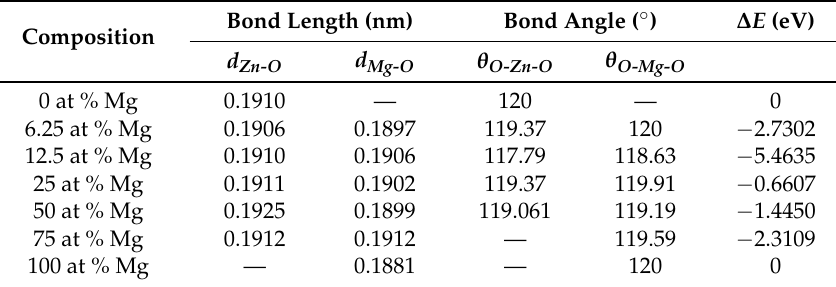
Table 1. The structural parameters and formation energies for MgZnO